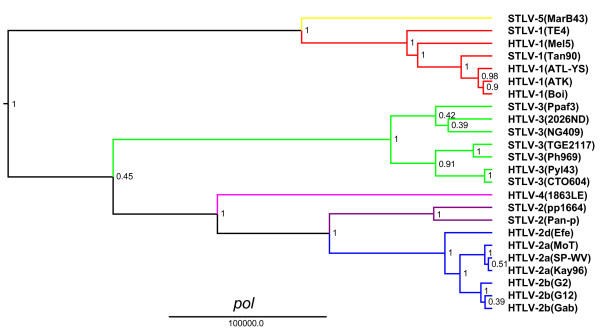
Phylogenetic relationship of HTLV-4(1863LE) to other PTLVs in pol using Bayesian inference. First and second codon positions of pol sequences were used to generate PTLV phylogenies by sampling 10,000 trees with a Markov Chain Monte Carlo method under a relaxed clock model, and the maximum clade credibility tree, i.e. the tree with the maximum product of the posterior clade probabilities, was chosen. Branch lengths are proportional to median divergence times in years estimated from the post-burn in trees with the scale at the bottom indicating 100,000 years. Posterior probabilities for each node are indicated. Branches leading to PTLV-1, HTLV-2 and PTLV-3 sequences are drawn in red, blue and green respectively. The branch leading to HTLV-4(1863LE), STLV-2, and to the divergent MarB43 strain are drawn in magenta, purple, and yellow respectively.